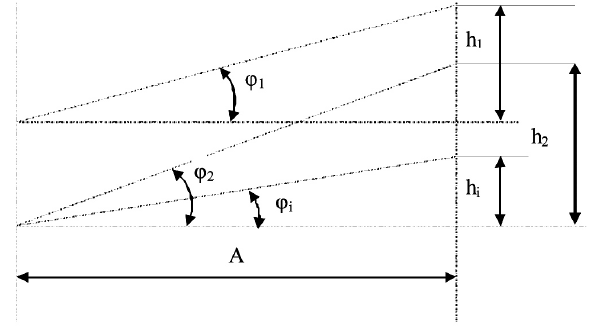
Fig. 3. a simplified diagram of angle measurement in the vertical